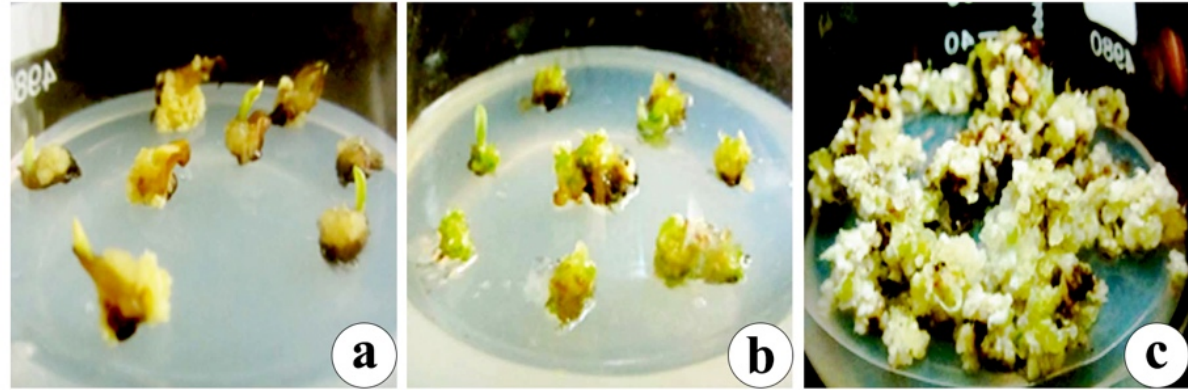
Figure 2. Response of GPUK-3 seeds on callus ( a ) initiation; ( b ) maintenance and ( c ) proliferation medium. The variety RK-390–25 was the least responding in terms of the percentage of callus produced, while GPUK-3 comparatively showed higher callus formation and shoot re-